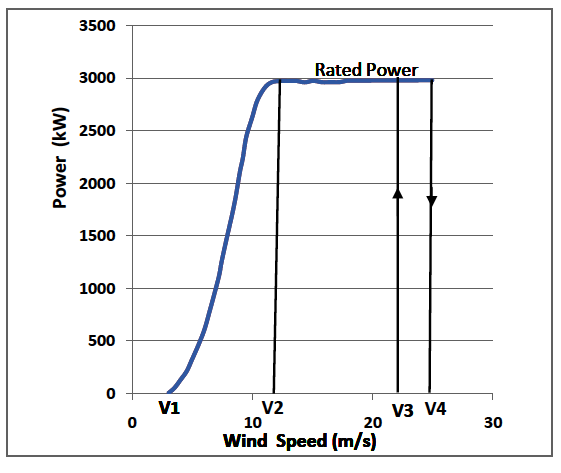
Figure 2. Wind turbine power curve: hysteresis.